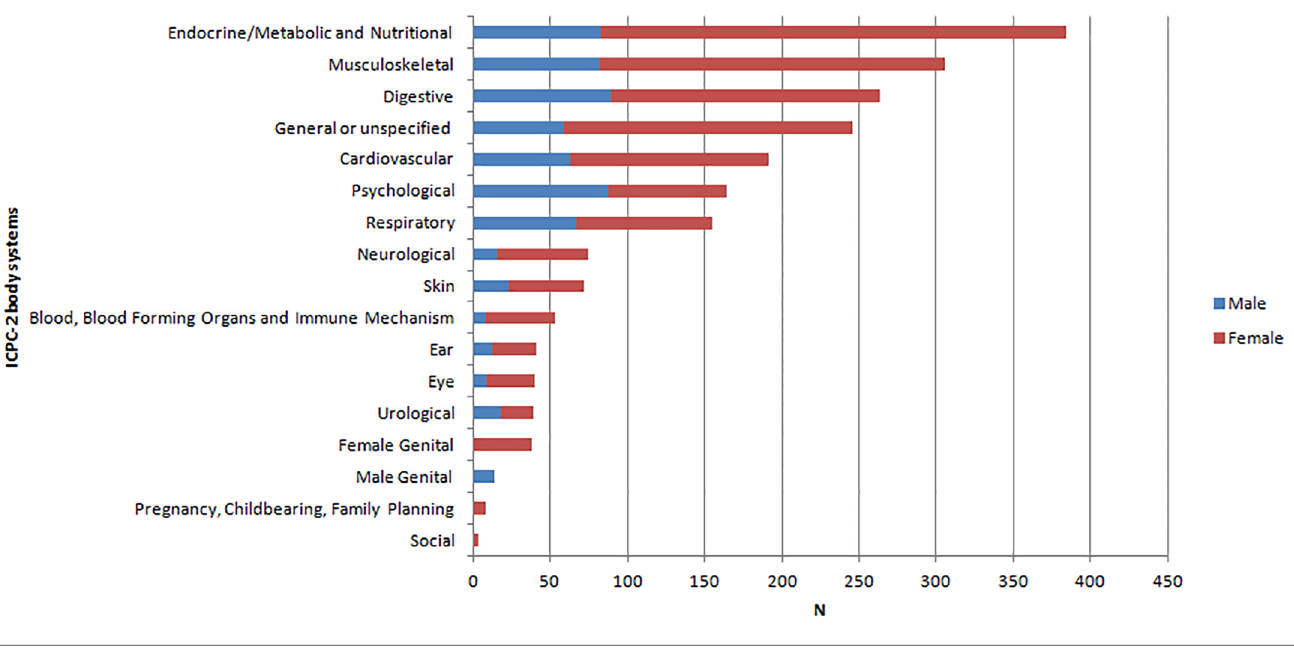
PLOS ONE | https://doi.org/10.1371/journal.pone.0201313 July 27,